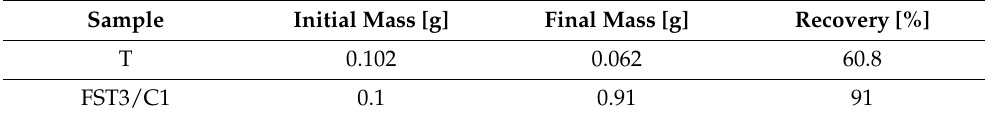
Figure 7. ( a ) Reusability/ recycling experiments for F, Sm 3+ co-doped TiO 2 /MWCNT and pure TiO 2 photocatalysts, and ( b ) XRD spectra for F, Sm 3+ Co-doped-TiO 2 /MWCNTs composites after photo- catalytic reaction to check the stability of the catalyst. Table 6. Photocatalyst recovery after five cycles of Table 6. Photocatalyst recovery after five cycles of use.